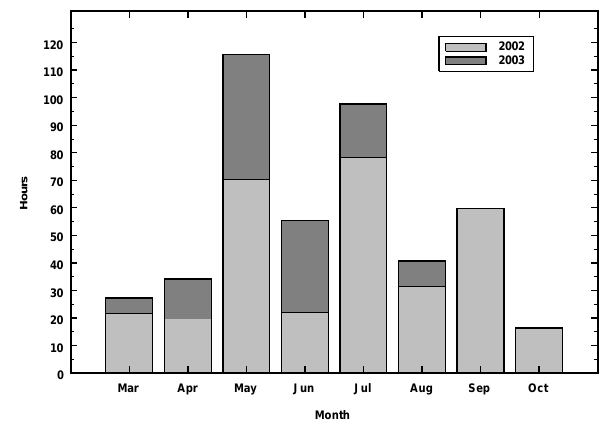
tions, in hours, at Rothera. The total number of hours in each month over the two years is given by the height of the bar, and the colour denotes the fraction of that total for the year 2002 (light grey) and 2003 (dark